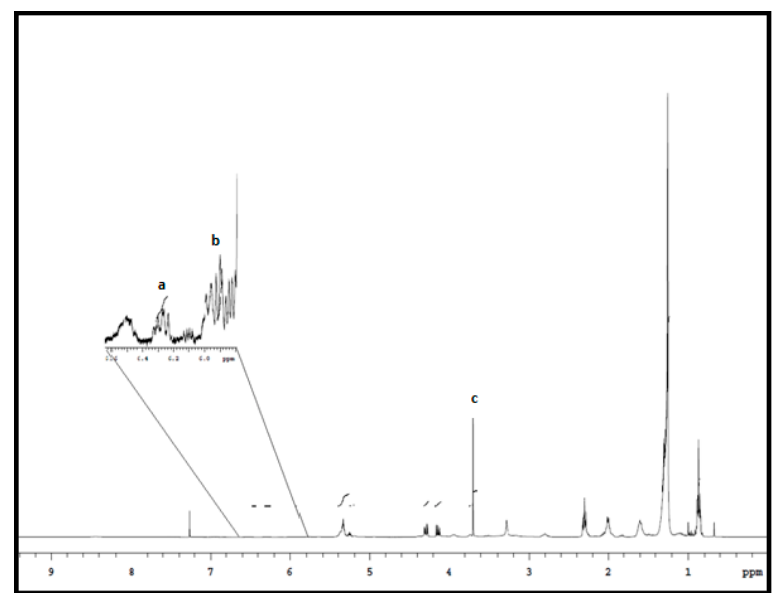
Figure 1. 1 H NMR spectrum for hot boned beef semimembranosus (SM) muscle lipid extract. The region 6.60–5.98 ppm was enlarged to visualize the integrated chemical shifts in analyzing the conjugated linoleic acid (CLA) concentration in the sample. CLA concentrations were obtained by averaging the integrated chemical shifts (peak a and b) shown above. Chemical shift (peak c) is the internal standard 1,4-dioxane used for quantitation of CLA in the study.